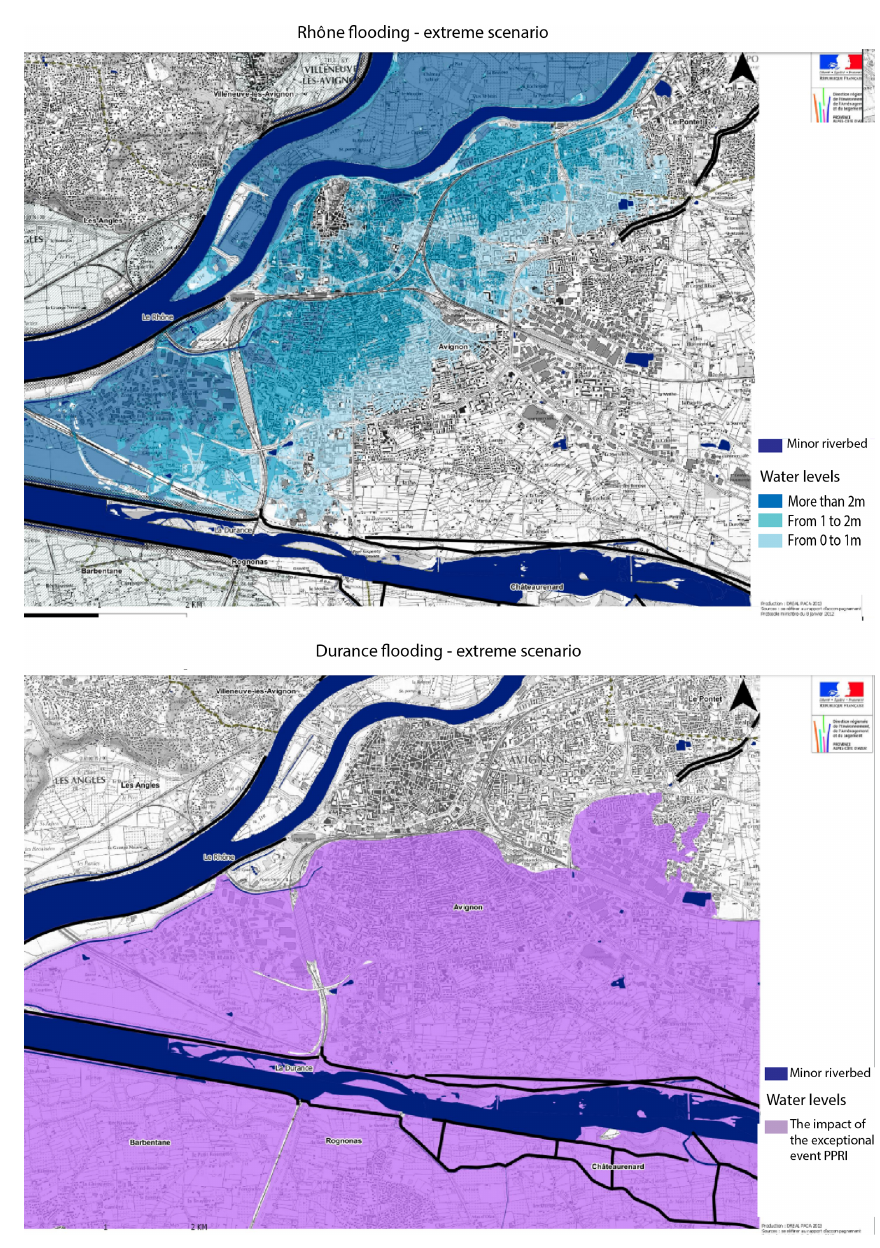
Figure 9. Extreme flood scenario in Avignon (Heinzlef et al., 2019), inspired by © DREAL